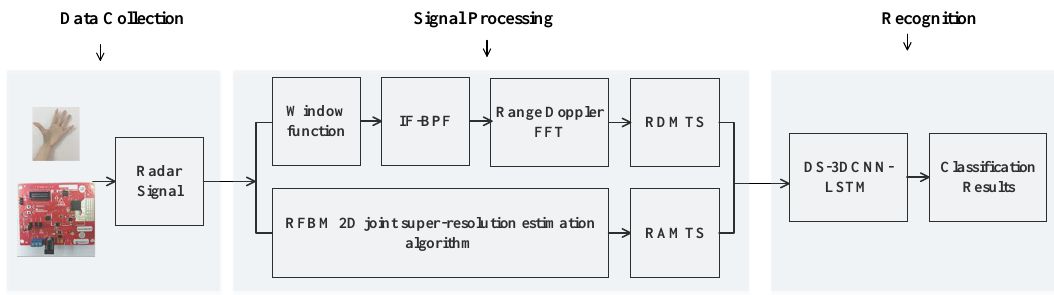
Figure 1. The overview of hand gesture recognition system.